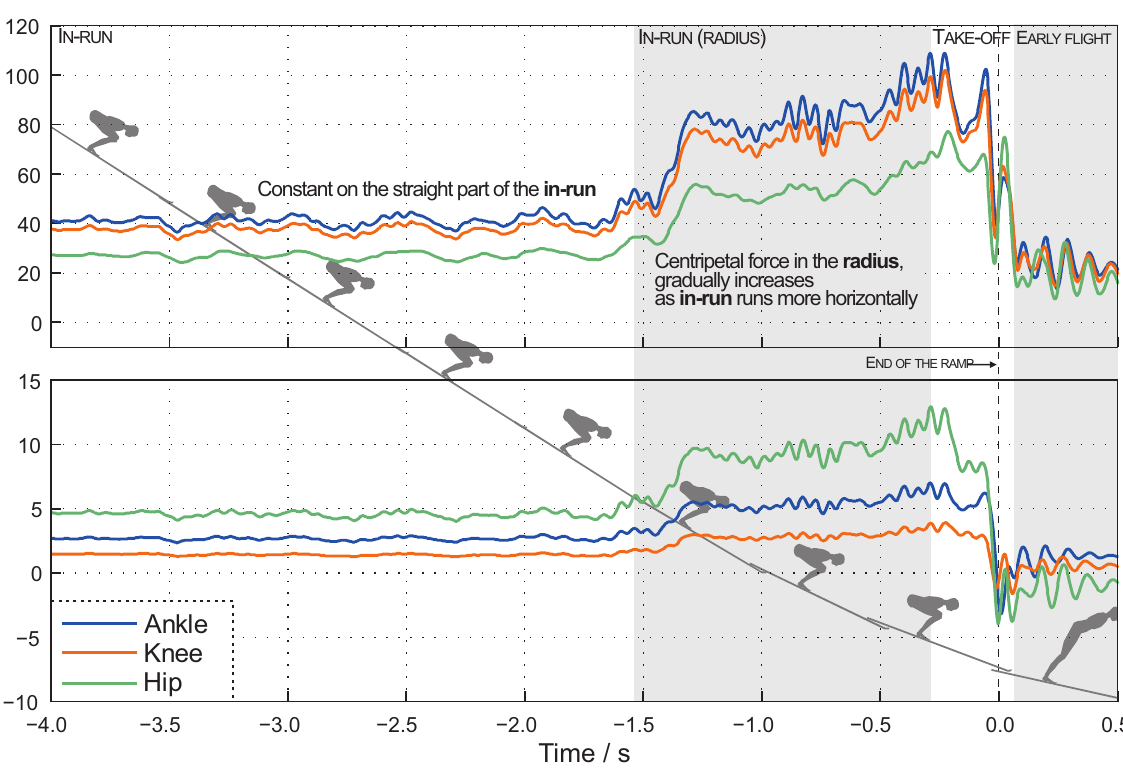
Figure 7. A comparison of the calculated forces and moments in the joints according to the top-down-up method during a ski jumping training session. The values represent one